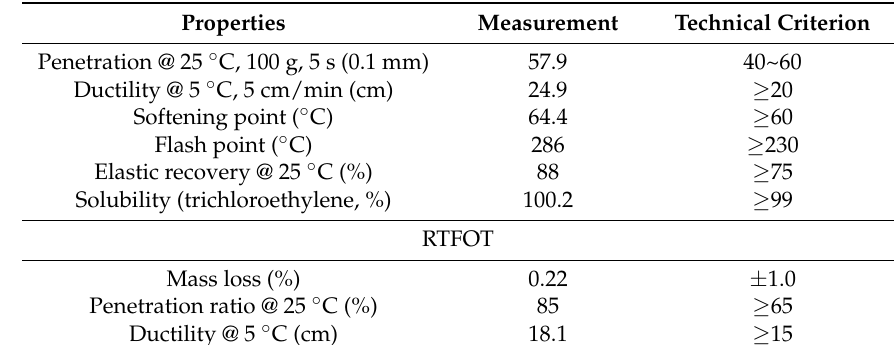
Table 1. Basic physical properties of SBS-modified asphalt.